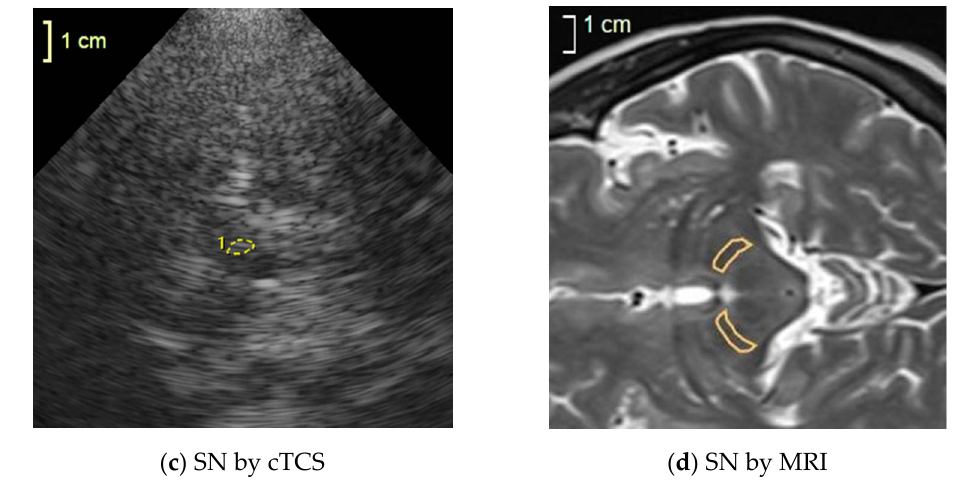
Figure 1. Regions of interest (ROI) examples in axial scanning plane images co-registered by different methods for the same healthy participant: ( a ) half of the midbrain in radiofrequency (RF) transcranial sonography (TCS) data-based B-mode image, ( b ) analyzed half of the midbrain and not-analyzed half of the midbrain mapped as root mean square (RMS) of confident displacements detected from RF TCS signal sequences; ( c ) substantia nigra (SN) in conventional TCS (cTCS) image of midbrain ( d ) SN by magnetic resonance imaging (MRI) of midbrain, T2W/TSE/2 mm sequences. Contours of ROI depicted in colorful lines (see online version). In sonography examples, the ultrasound transducer was on the left side of the head or at the top of images.